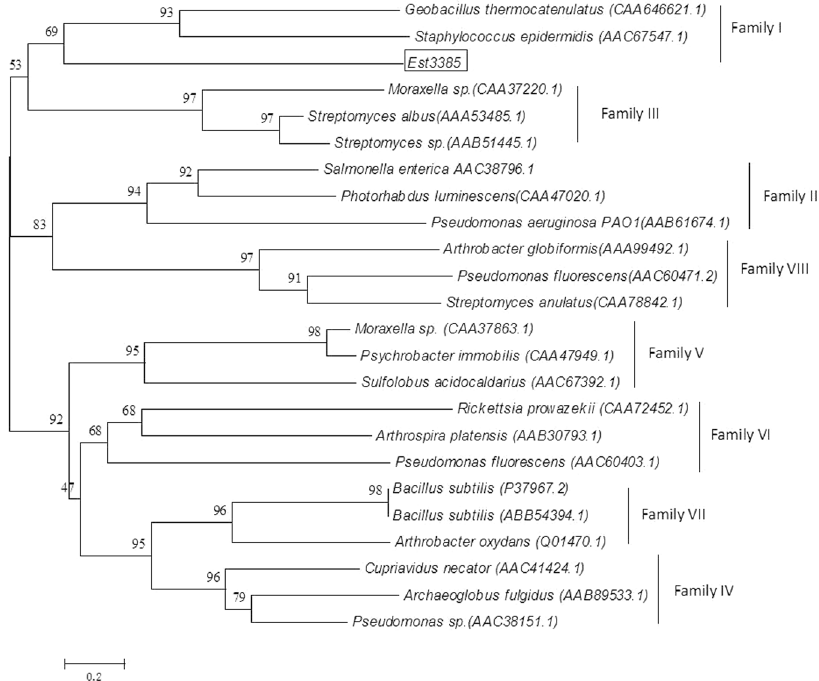
Figure 1. Phylogenetic relationship between Est3385 and other proteins belonging to different esterase families. The number in the brackets are the accession numbers of individual protein sequences, while the boxed sequence is